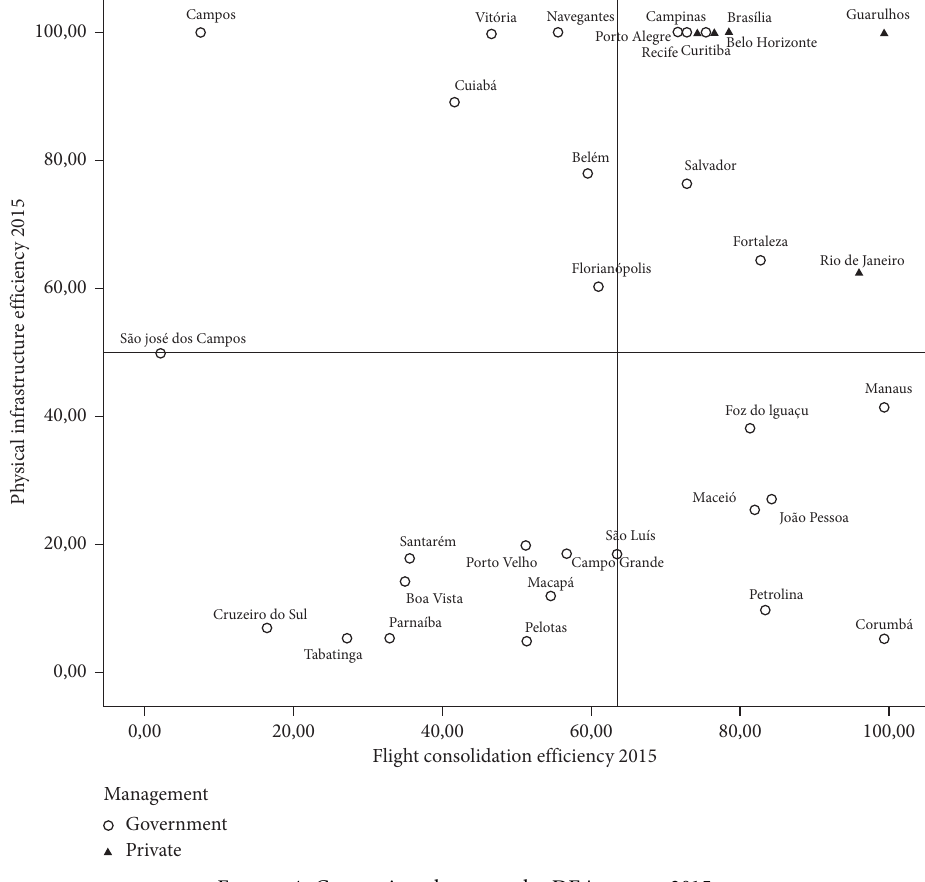
Figure 4: Comparison between the DEA stages, 2015. Table 6: Hypotheses testing for the DEA efficiency averages.